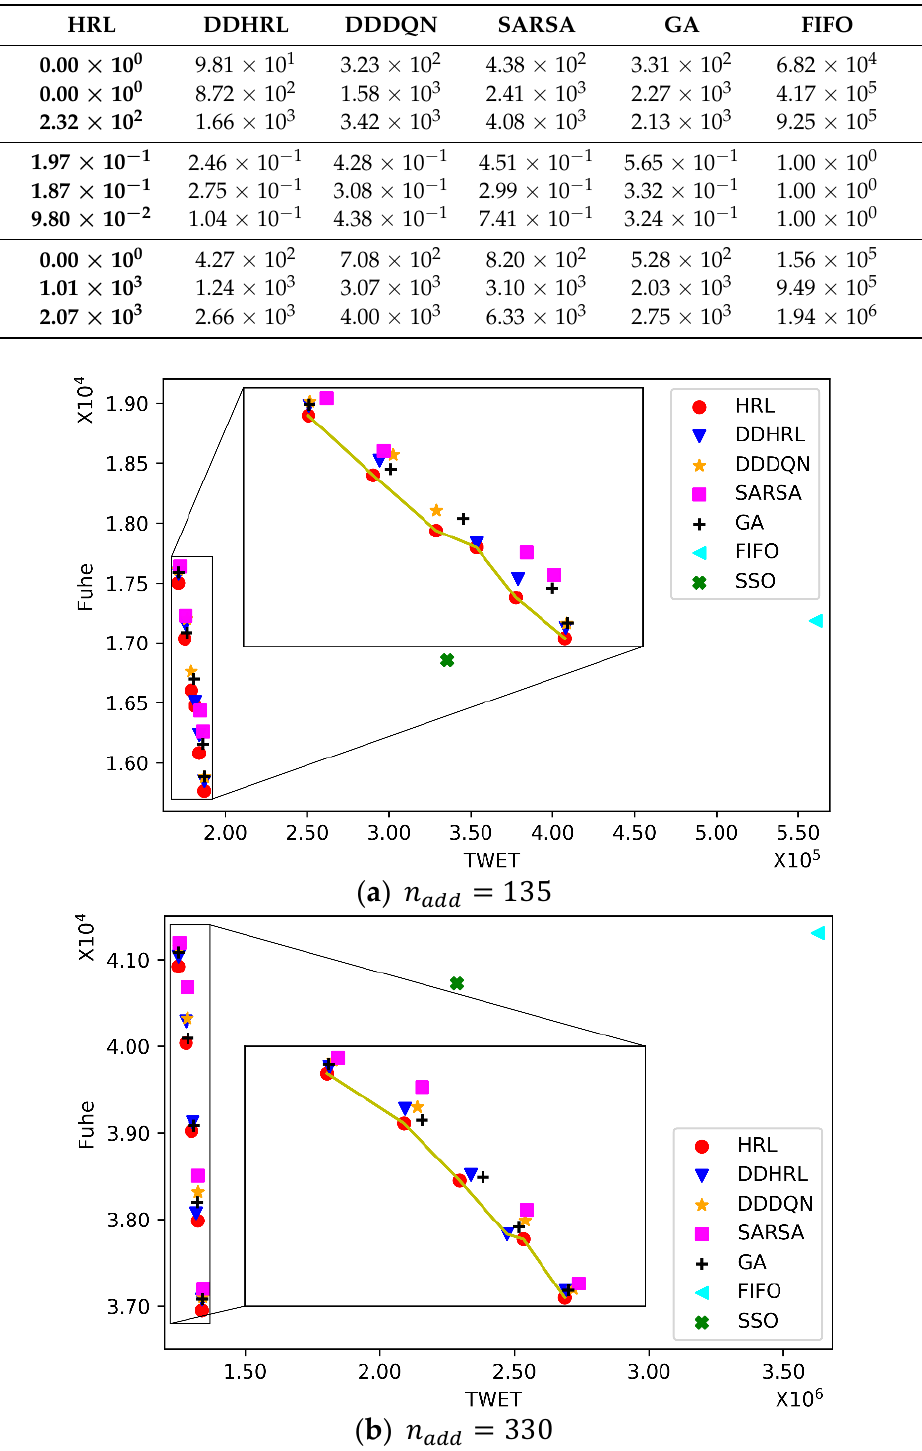
Table 6. Metric values for the Pareto-optimal fronts obtained by comparative methods, with the best results in bold.